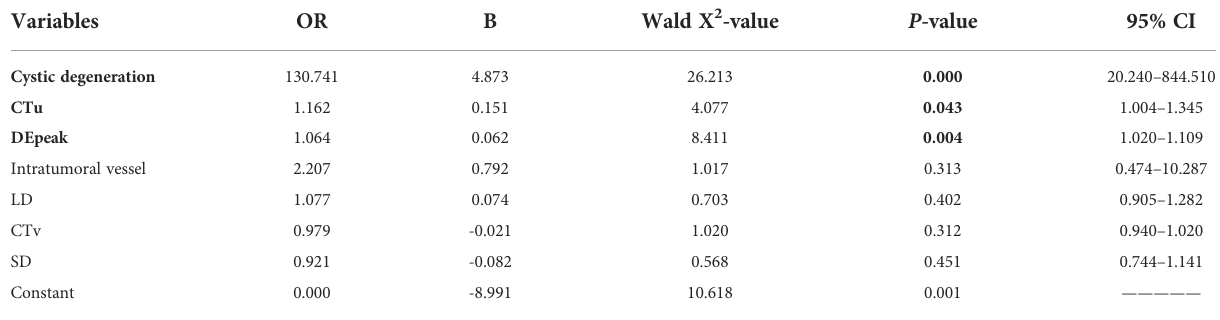
TABLE 4 Binary regression analysis for identifying adrenal PCCs in group 2 on the training